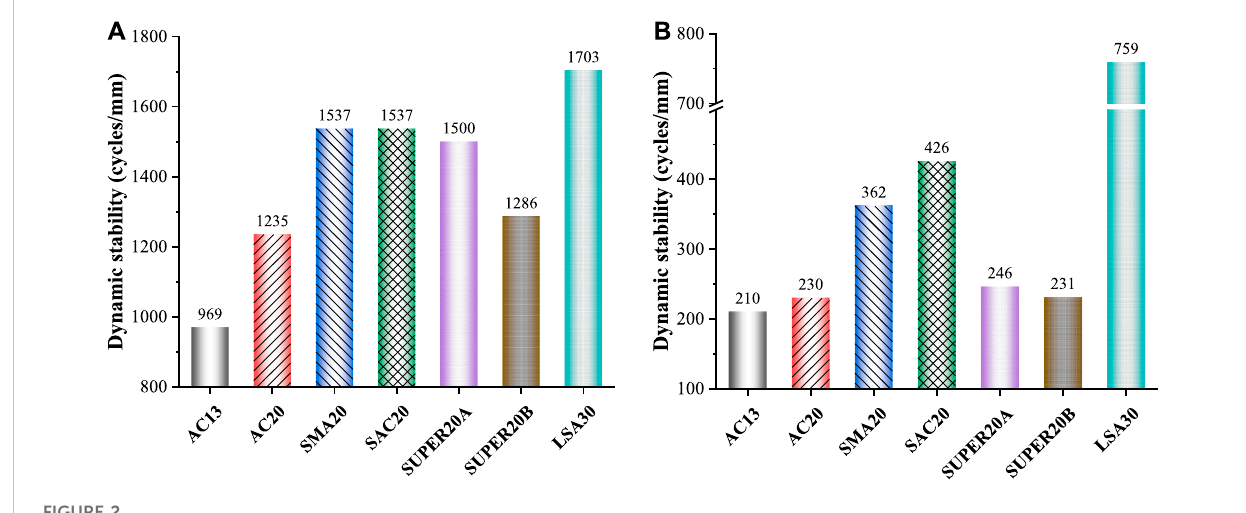
FIGURE 2 Dynamic stability versus gradation types under different tire pressures: (A) 0.7 MPa and (B) 1.44